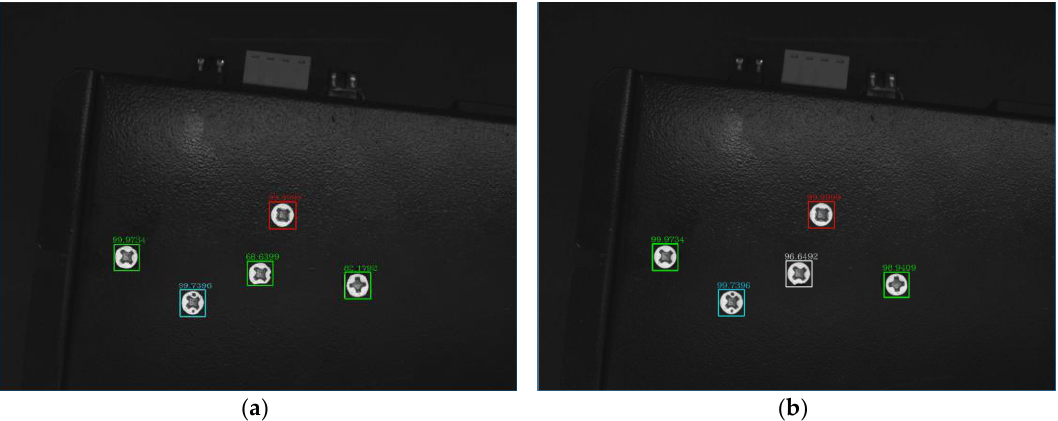
Figure 18. The test results of two models. ( a ) The test results of LeNet-5; ( b ) The test results of the proposed DCNN.